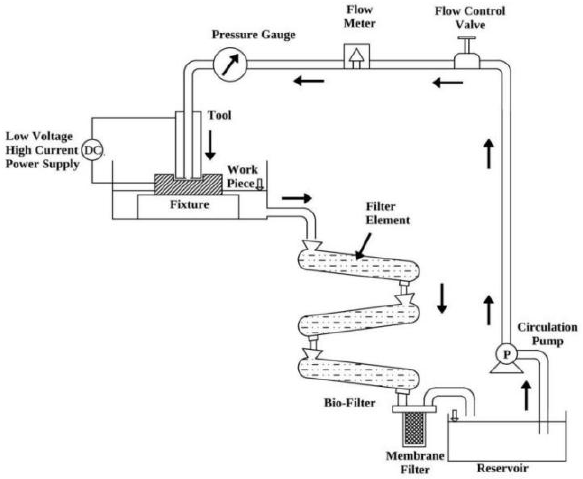
Figure 1. Schematic diagram of EECM.